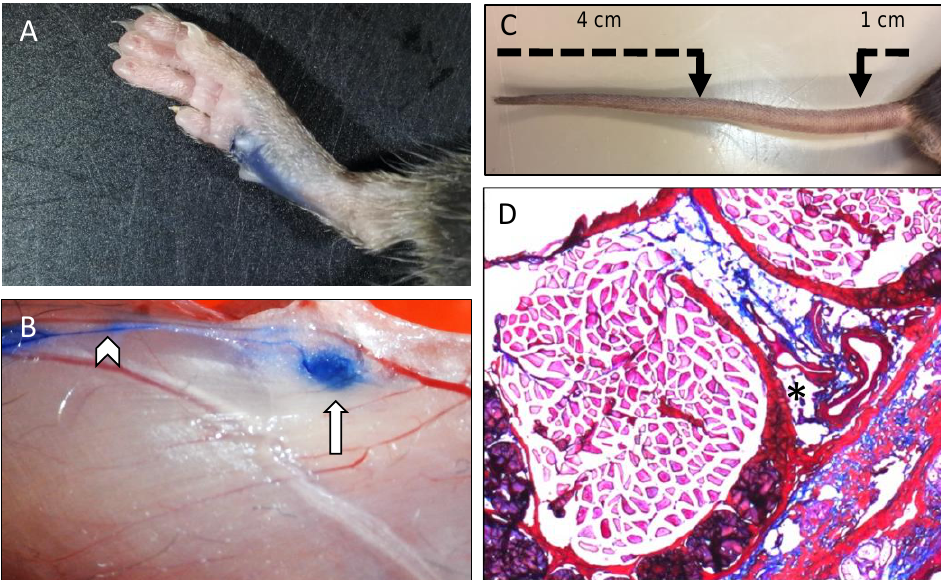
Figure 2. Methods to determine drainage of interstitial fluids. ( A ) Photograph shortly after injection of 5 microliters of 5% Evans blue in the footpad. ( B ) Representative image illustrating draining through lymphatic vessels (arrowhead) to a draining lymph node (arrow) at 15 min after the footpad injection with Evans blue. ( C ) The tail diameter is typically measured with a caliper at two different locations (1 cm from the basis and 4 cm from the tip of the tail) to determine swelling, indicative of the presence of edema. ( D ) Representative image of Masson’s trichrome staining on a tail cryosection illustrating the presence of edema in close proximity to blood and lymphatic vas- culature (black asterisk).